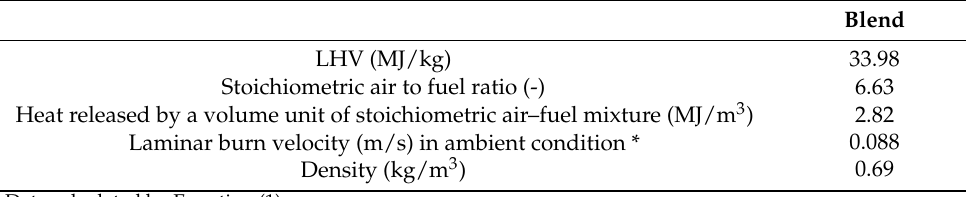
Table 3. Fuel blend properties (ammonia 85%–hydrogen 15% by